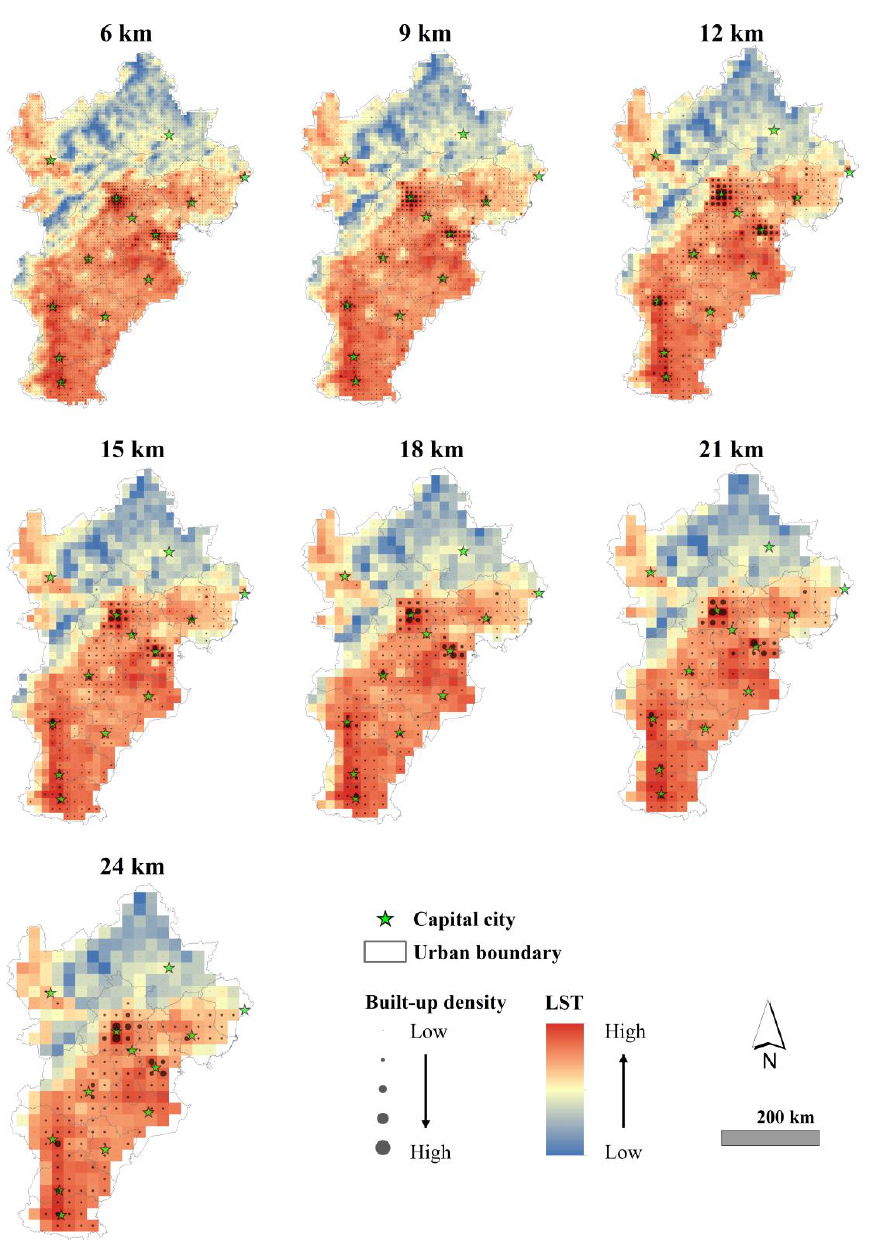
Figure 4. Example of the spatial distribution for summer land surface temperature (LST) and built-up density of the BTH region in